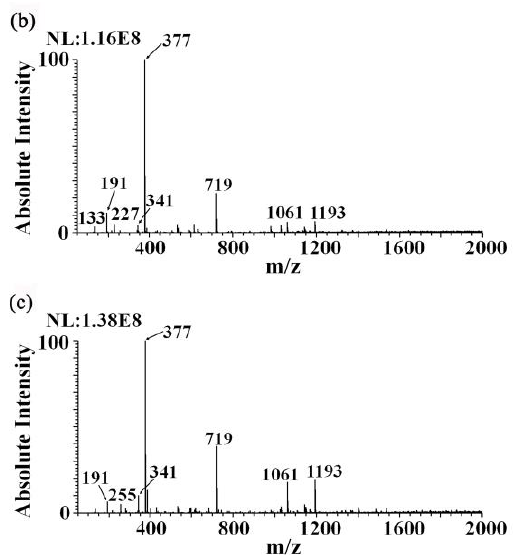
Figure 2. The fingerprint data of methanol (0.5 mM ammonium chloride) extracted from three samples detected using iEESI-MS: ( a ) fingerprint data of the ginseng under forest sample, ( b ) fingerprint data of the Panax quinquefolium (Canada) sample, and ( c ) fingerprint data of the Panax quinquefolium (Jilin) sample.